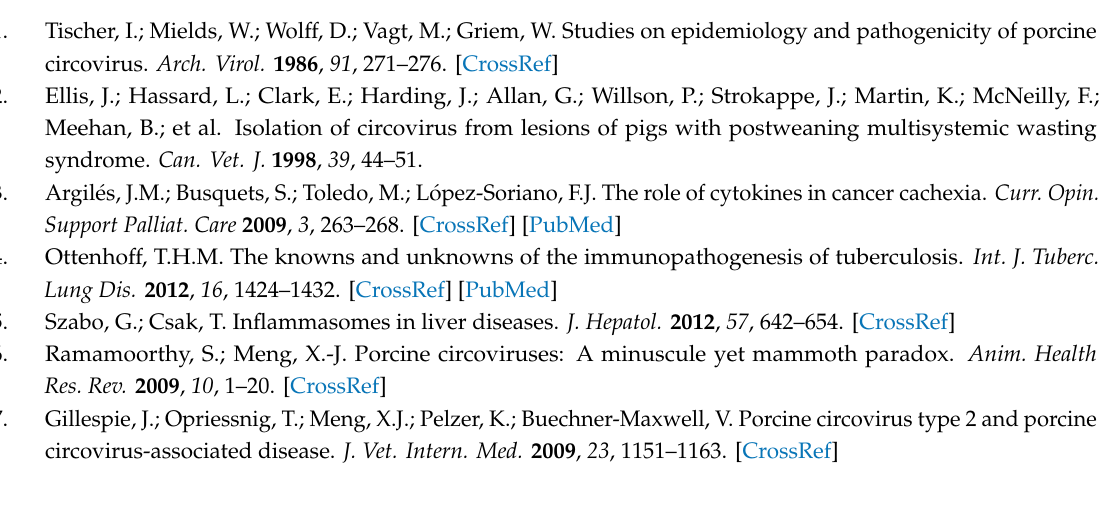
Table S1: Species S nonV group before experiment; Table S2: Species S V group before experiment Species S V group before experiment; Table S3: Species RF nonV group before experiment; Table S4: Species RFV group before experiment; Table S5: Species S nonV group after experiment; Table S6: Species SV group after experiment; Table S7: Species RF nonV group after experiment; Table S8: Species RFV group after experiment; Table S9: Di ff erences between microbiological parameters of the piglets’ faeces between all the tested groups; Table S10: Di ff erences between blood parameters of the piglets between all the tested